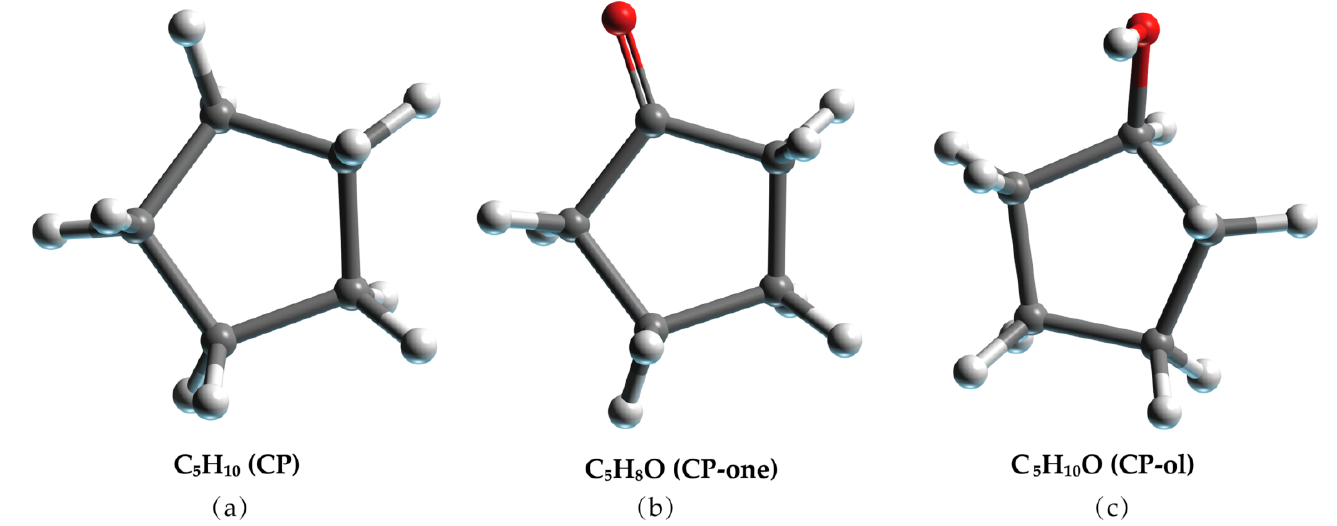
Figure 9. Molecular model of ( a ) CP, ( b ) CP-one, and ( c ) CP-ol. The gray, red, and white balls represent C, O, and H atoms, respectively. Table 1. The LCCBM hydrate model.